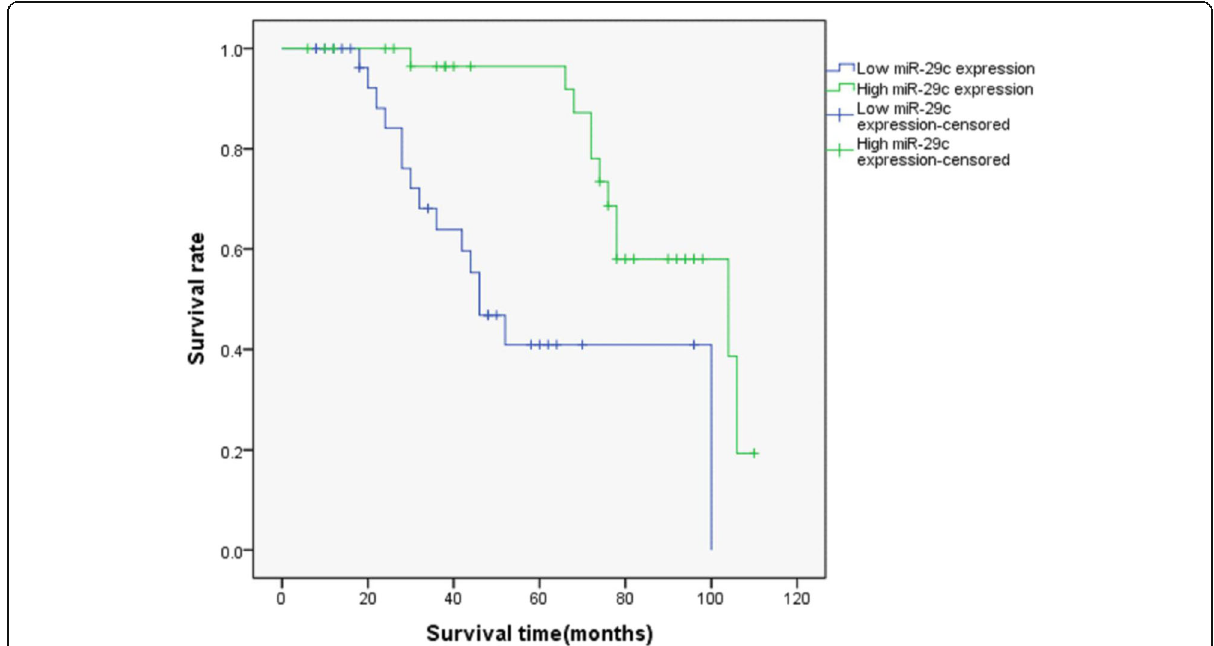
Fig. 3 MiR-29c expression was relative to patient prognosis in LSCC. The survival rate in different miR-29c expression groups showed significant differences, p < 0.05